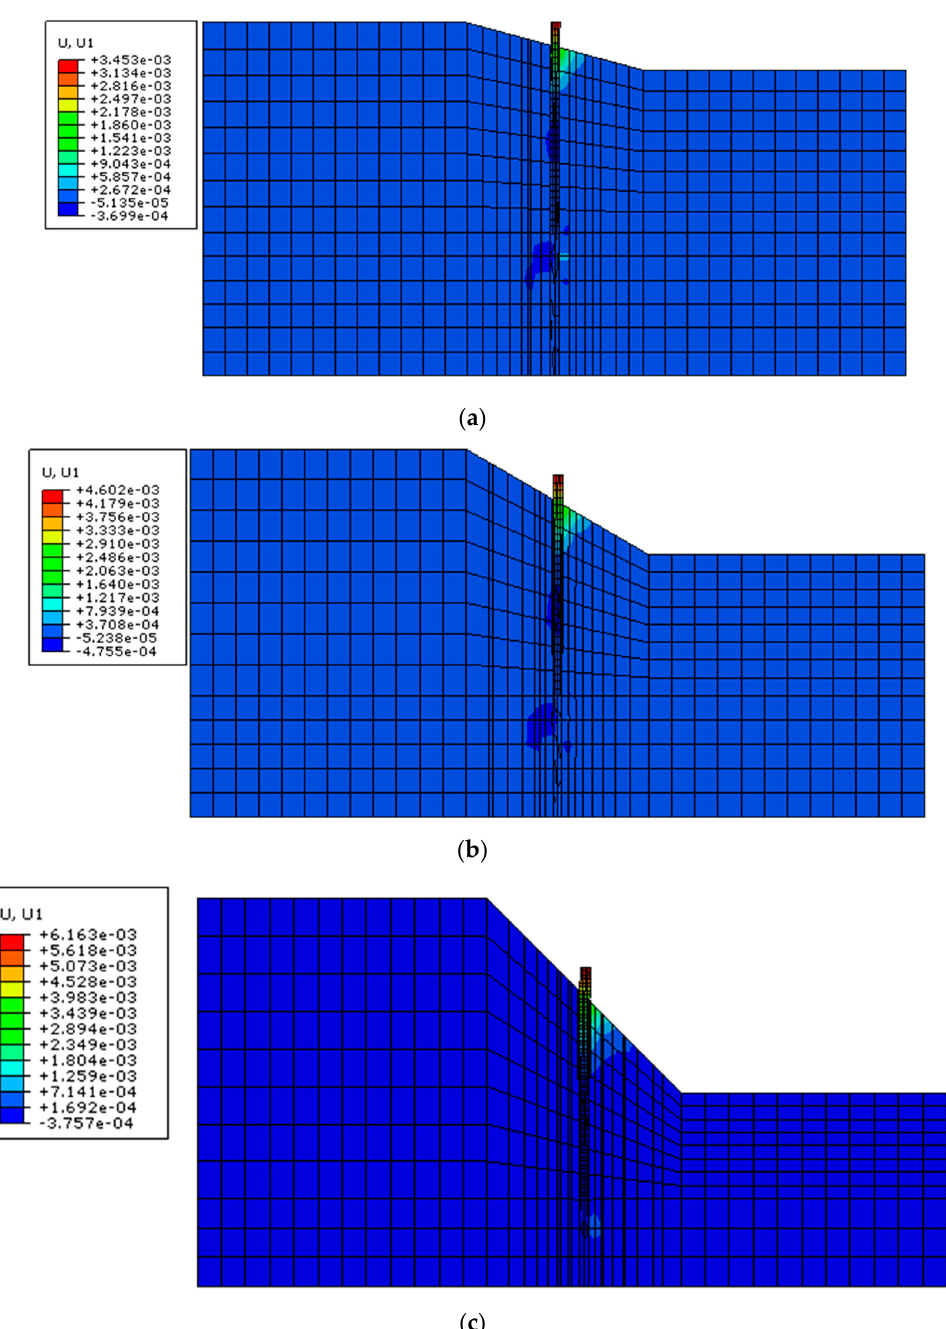
Figure 9. The displacement of pile–soil interaction under the lateral load of 450 N (unit: m): ( a ) horizontal displacement of 15° slope angle; ( b ) horizontal displacement of 30° slope angle; ( c ) horizontal displacement of 45° slope angle.